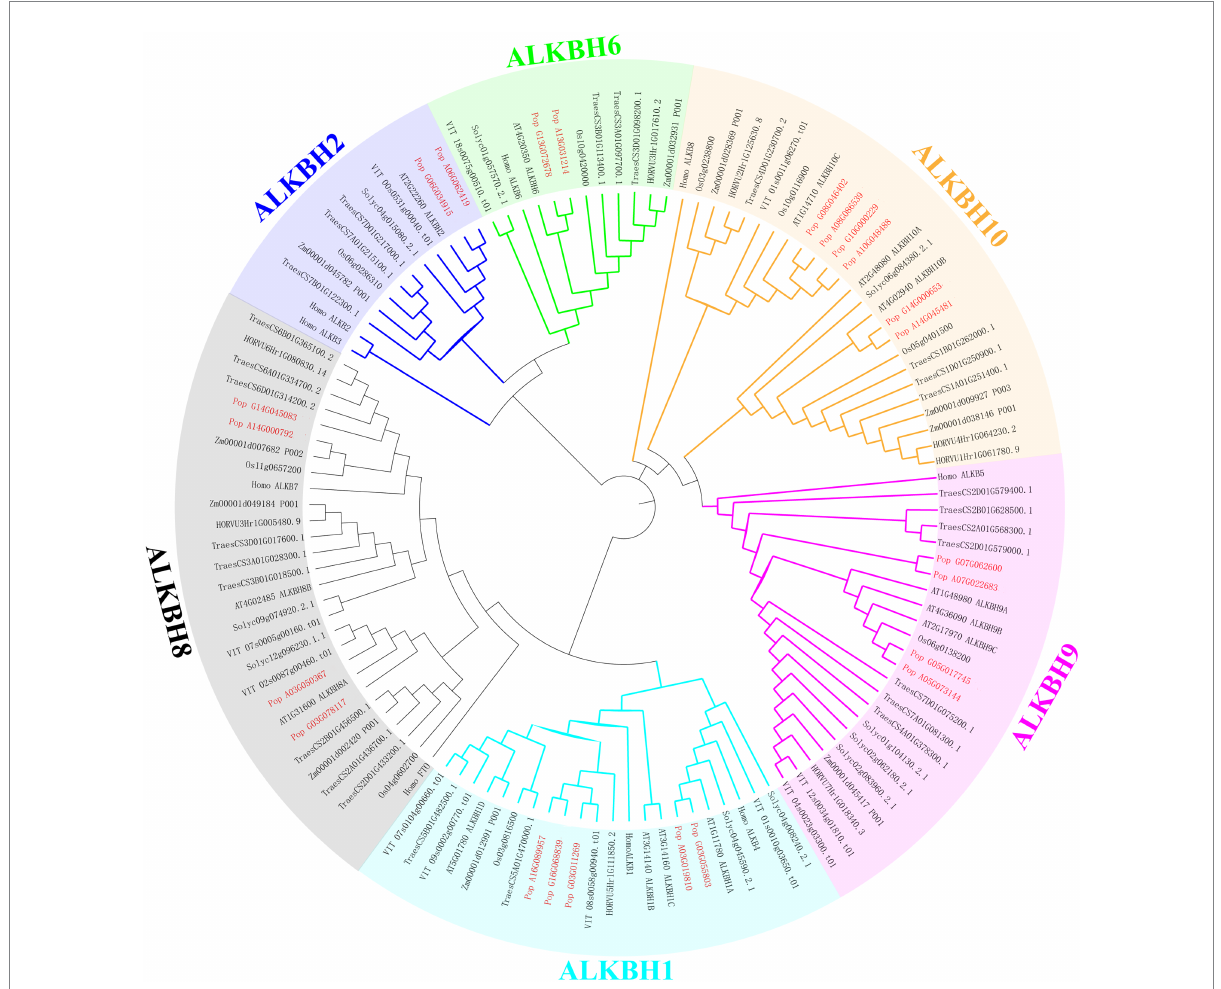
FIGURE 2 Phylogeny of ALKBH proteins. Phylogenetic relationships of human ( Homo sapiens ) Arabidopsis ( A. thaliana ), maize ( Zea mays ), rice ( Oryza sativa ), wheat ( Triticum aestivum ) tomato ( Solanum lycopersicum ) barley ( Hordeum vulgare ) grape ( Vitis vinifera ), and poplar 84K ( Populus alba × P. tremula var. glandulosa ) were estimated using maximum likelihood. Different colors represent different